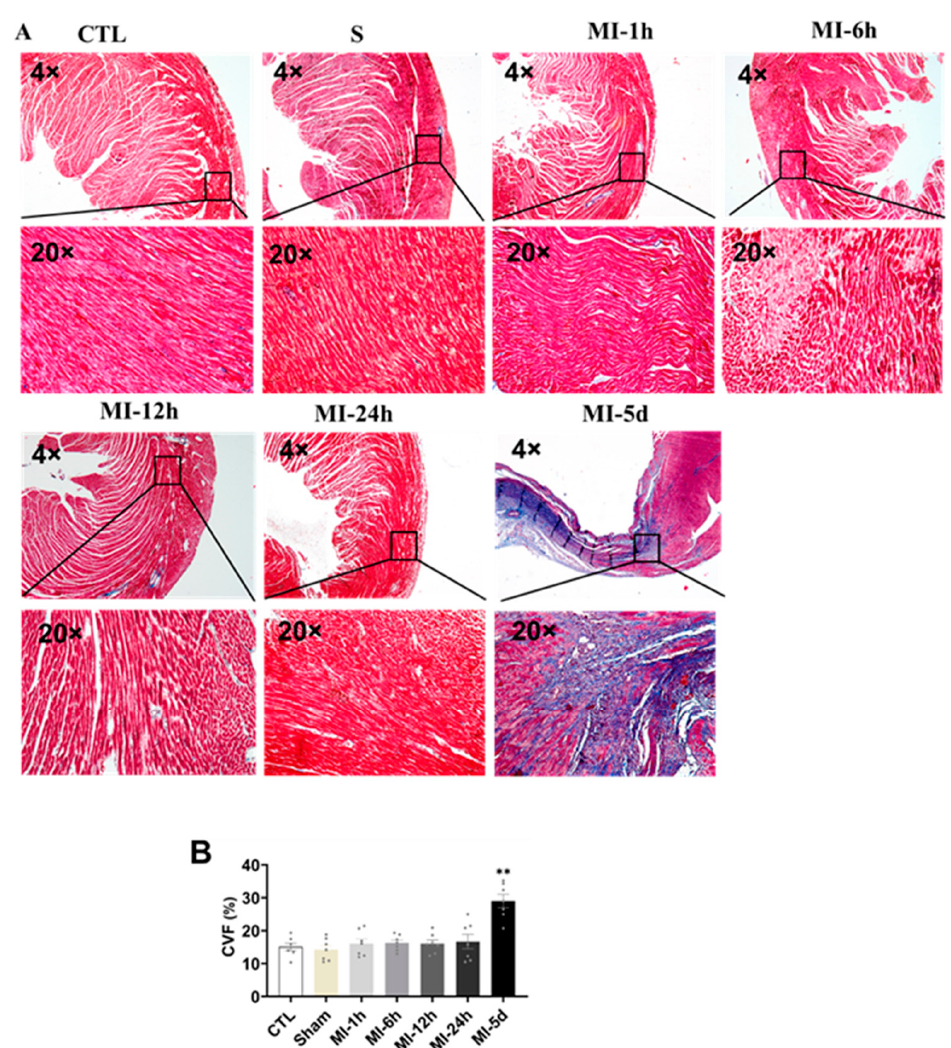
Figure 4. Tests of myocardial fibrosis after MI. Blue collagen, a fibrosis marker, red cardiac muscle fibers, and nuclei in dark brown emerged in the microscopic images. ( A ) Masson-negative staining portions (cardiac muscle fibers) and Masson-positive staining portions (blue collagen) were digitally measured by collagen volume of fraction (CVF %) ( n = 3). ( B ) Values presented are the means ± SEM. CTL, normal control; sham; MI-1 h, 1 h after MI; MI-6 h, 6 h after MI; MI-12 h, 12 h after MI; MI-24 h, 24 h after MI; MI-5d, 5 days after MI (** p < 0.01 vs. sham).